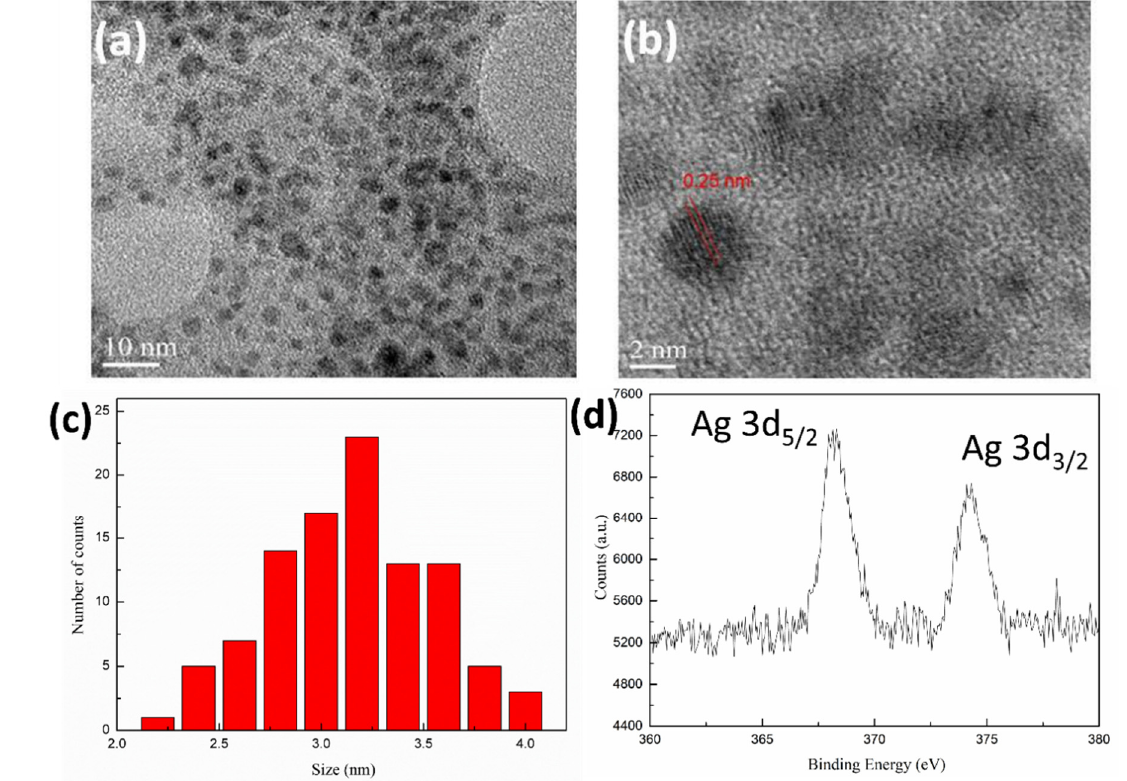
Figure 6. ( a ) High resolution (HR)TEM images of as-synthesized 8PEG-AgNCs nanohybrids, ( b ) Lattice fringes of AgNCs, ( c ) Particle size distribution and ( d ) X-ray photoelectron spectroscopy (XPS) characterization of 8PEG-AgNCs.